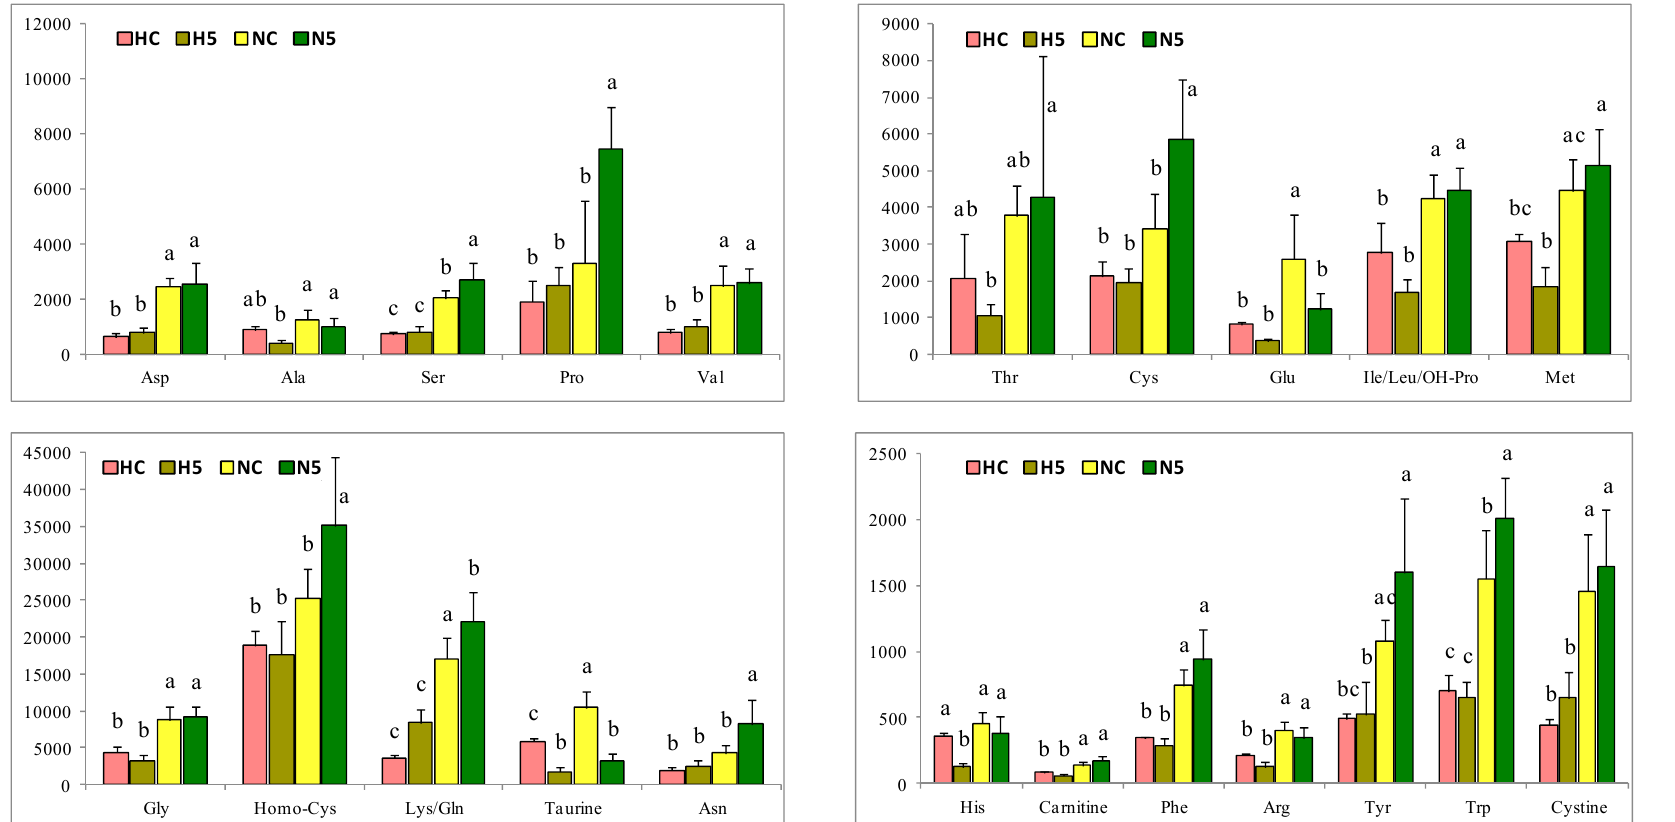
Figure 5. Amino acid content in the liver of rats of the four experimental groups (HC: high fat diet, H5: high fat diet + 5% spinach, NC: standard diet and N5: standard diet + 5% spinach). The bar height indicates the mean value of each feed condition and the error bar indicates the standard deviation. a–c Different letters indicate significant statistical differences ( p < 0.05).